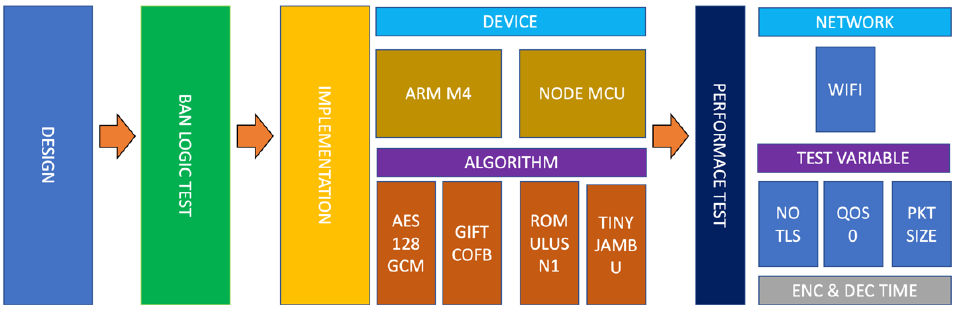
Figure 1. Research Flow.